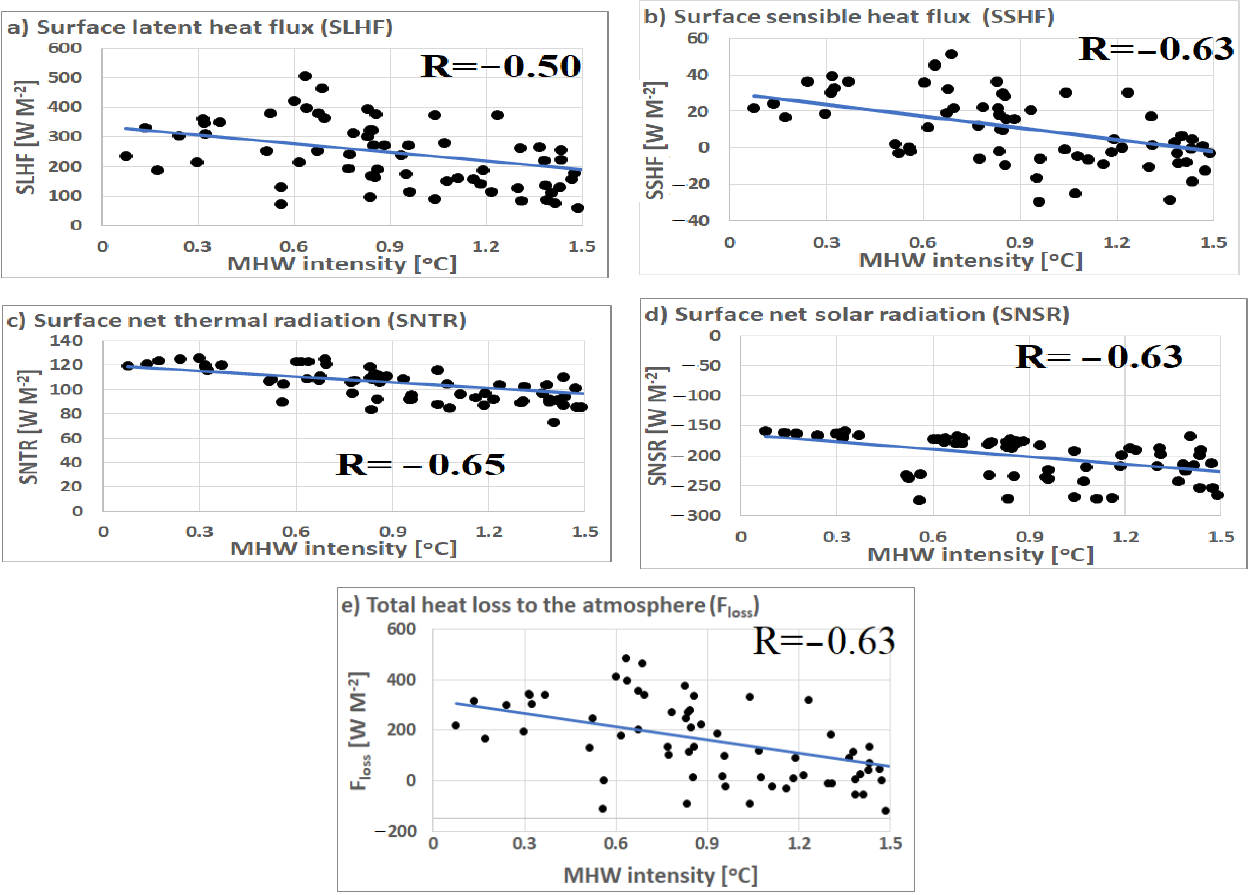
Figure 18. Scatter plots of marine heat wave intensity during the study case 4 (30 August 2020 to 5 December 2020) and surface latent heat flux ( a ), surface sensible heat flux ( b ), surface net thermal radiation ( c ), surface net solar radiation ( d ), and total heat loss to the atmosphere ( e ).